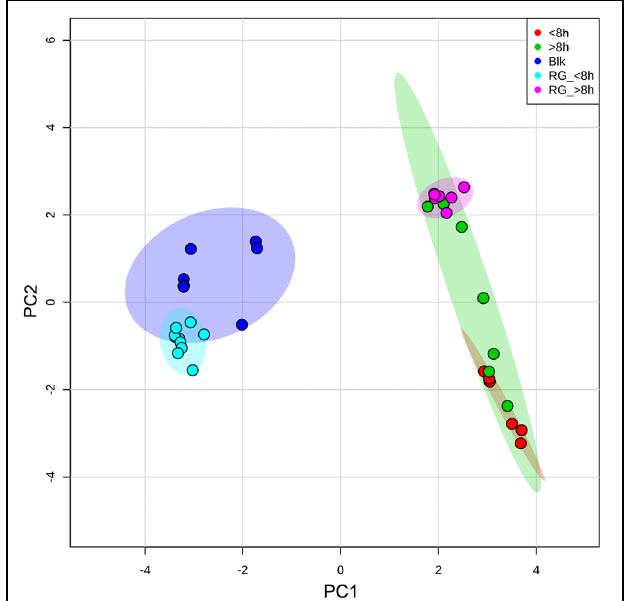
FIGURE 5 | Scores plot between PC1 and PC2. The data are represented according to the time of exposure to antibiotics ( < 8 and > 8 h) and the duration of exposure to antibiotics prior to growth on drug-free medium (RG_ < 8 h; RG_ > 8 h). The colored areas represent 95% confidence